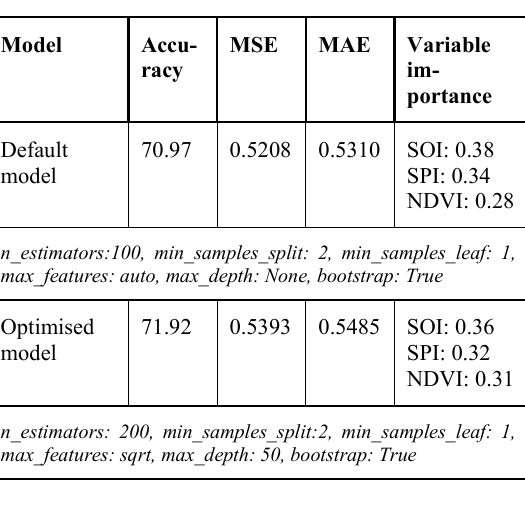
Table 2 . Results of Random Forest Regression. The default, baseline model is listed, as well as the best model according to the Randomised Search Cross validation.